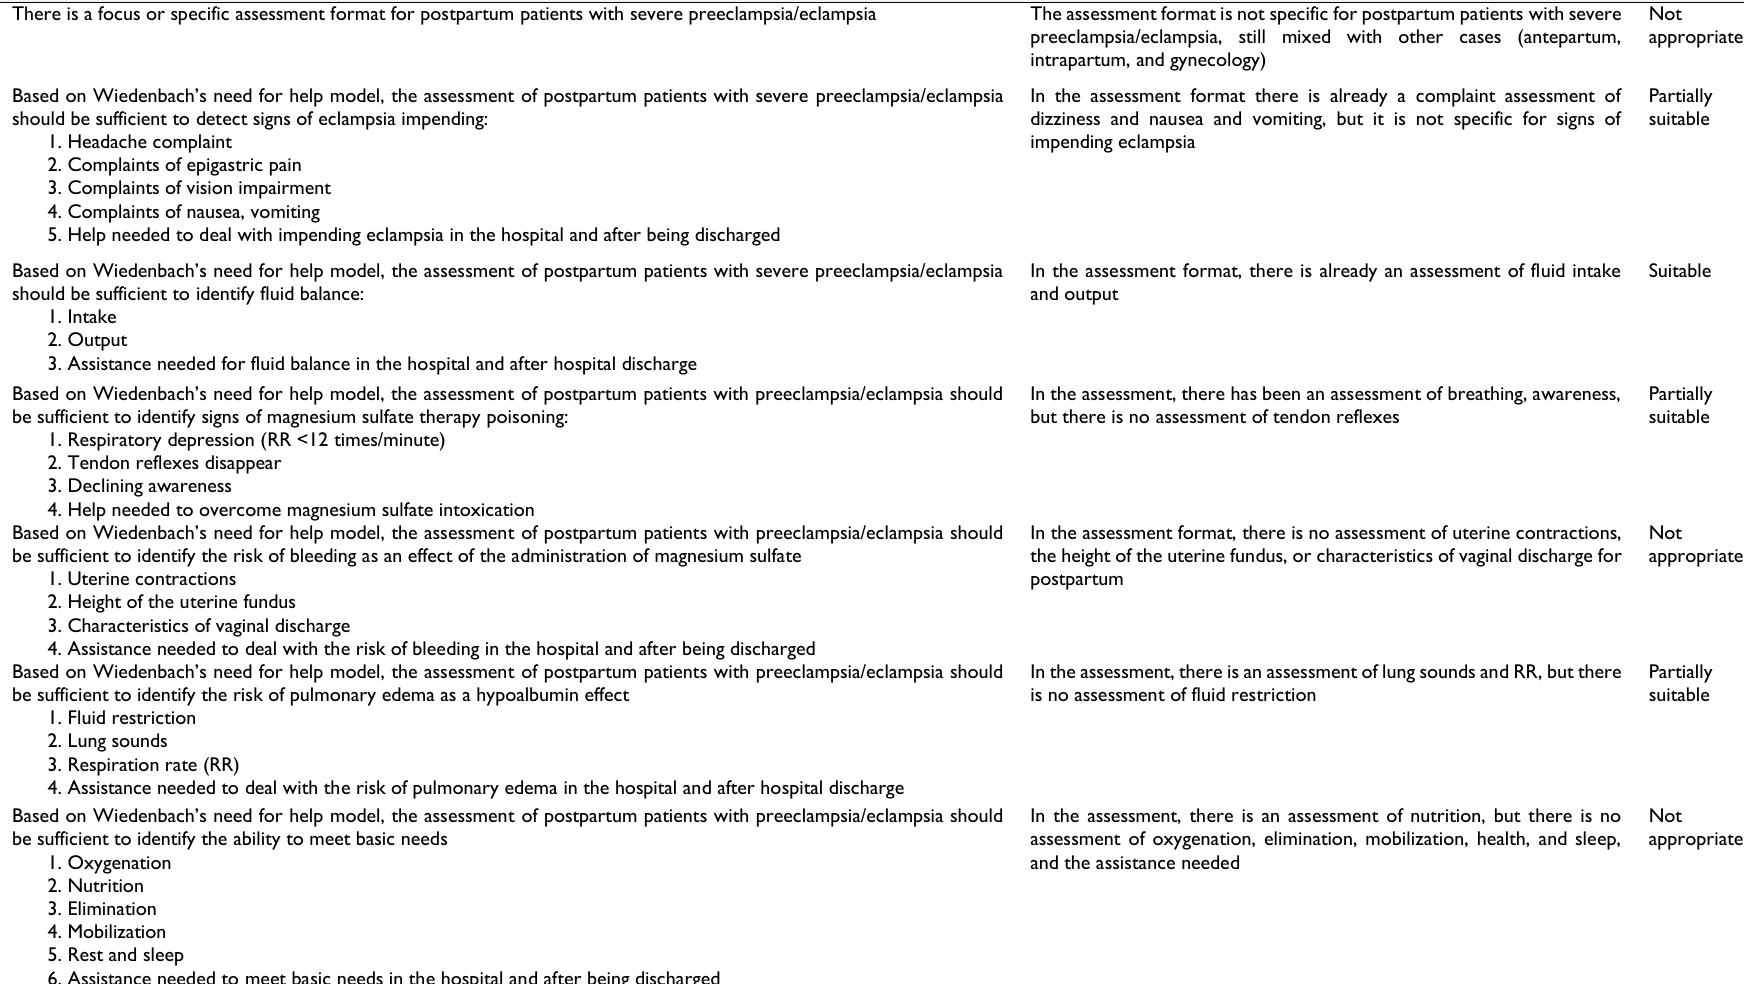
Instrument Standards